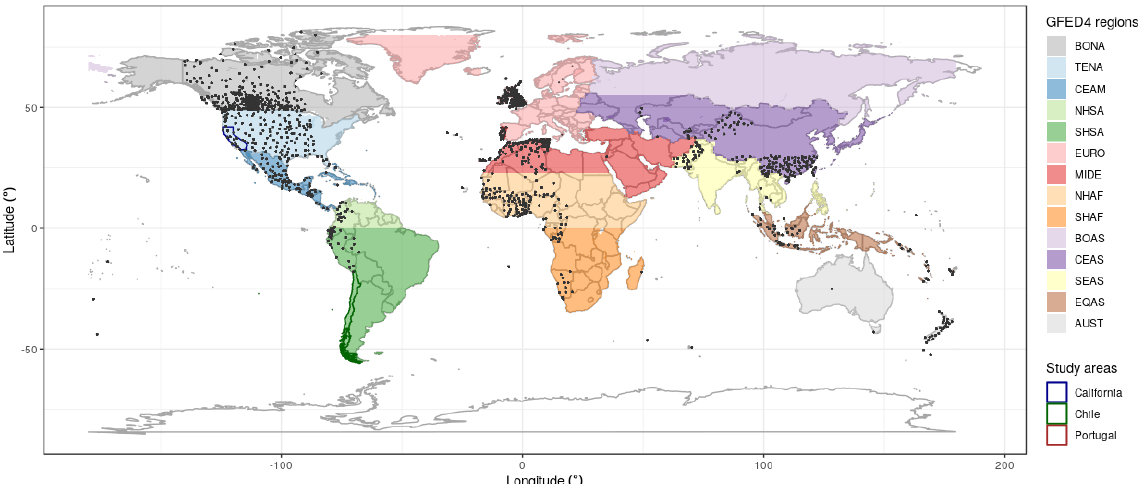
Figure 1. GFED4 regional classification and the three regions selected to showcase the fire forecast performances (California, Chile and Portugal). The black dots show the spatial distribution of weather stations from the SYNOP network which have at least 30 observations recorded at 12:00LT in